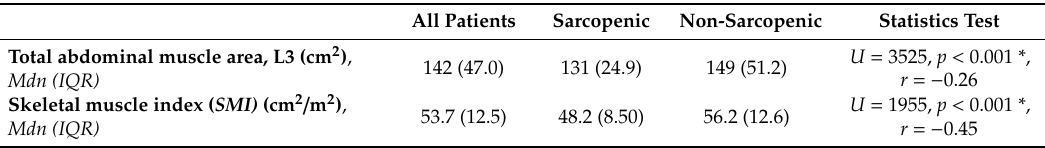
Table 2. Relationship between sarcopenia and body composition